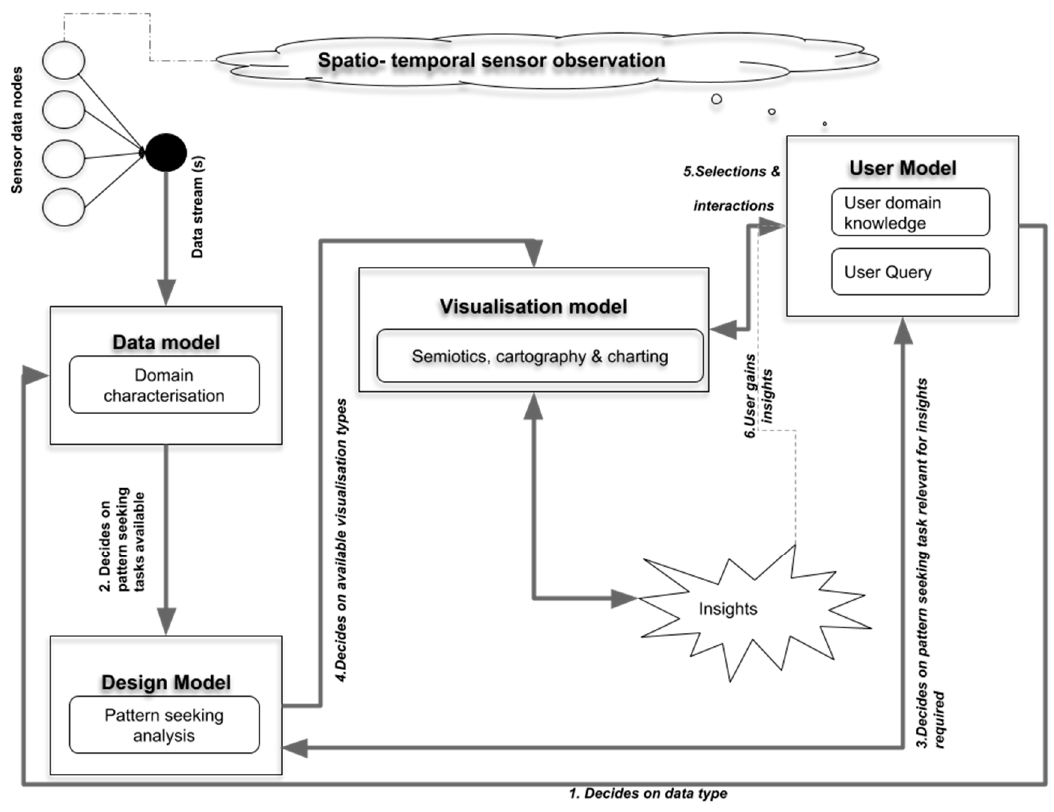
Figure 3. An overview of the relationships between components in the conceptual model.